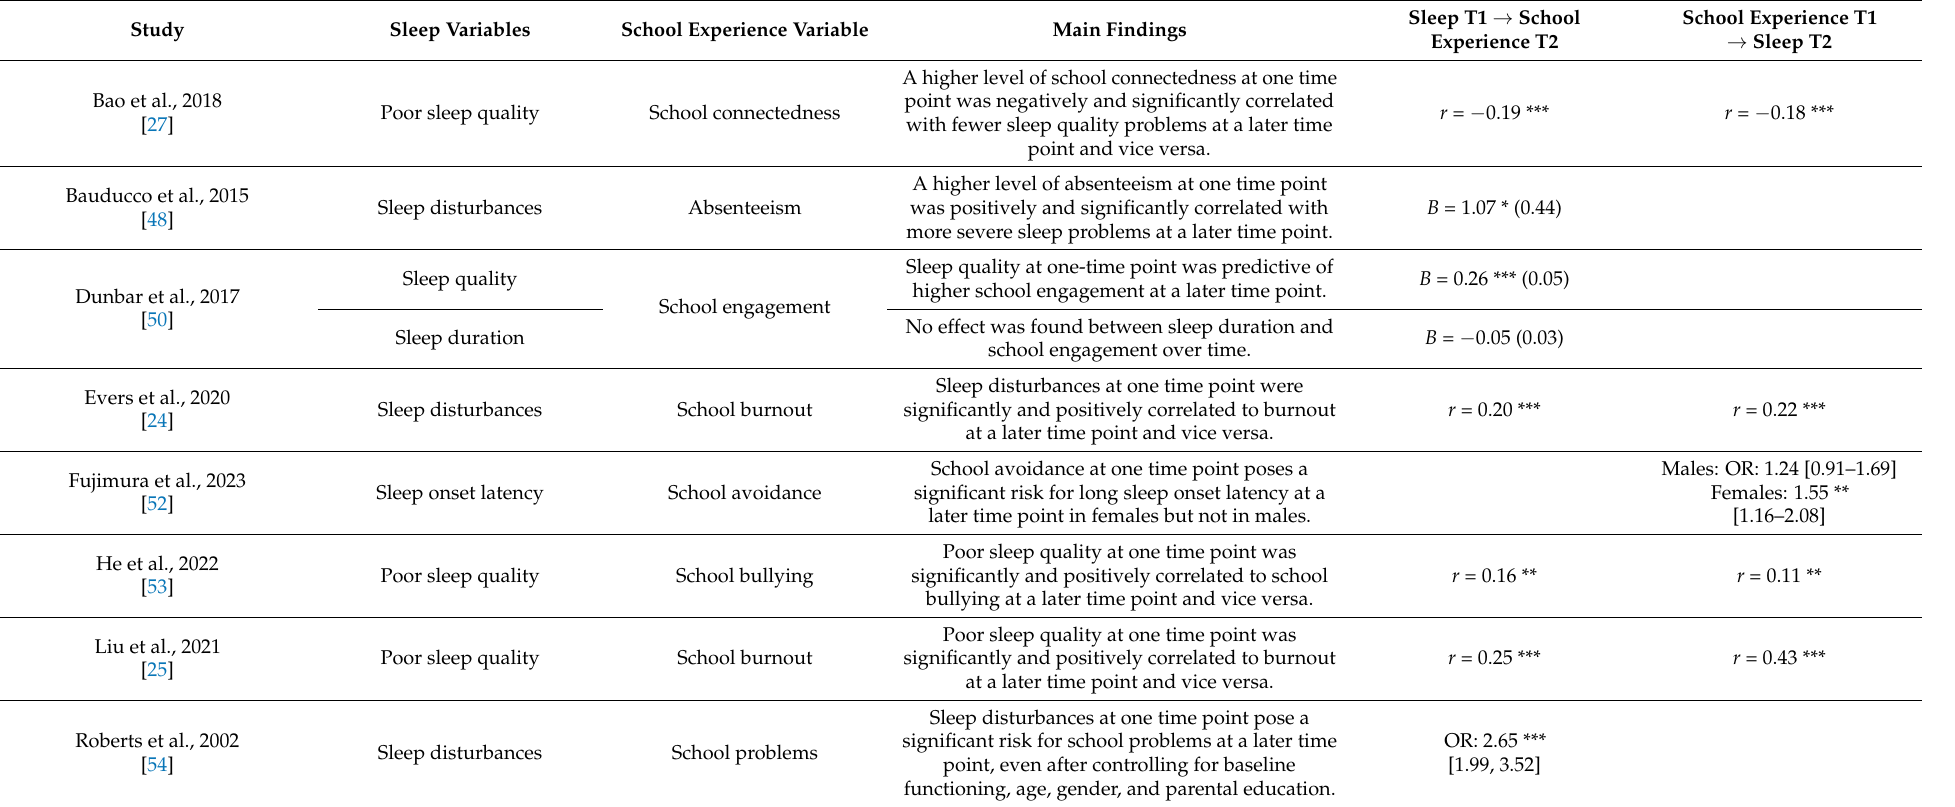
Table 4. Longitudinal associations between sleep and psychological aspects of